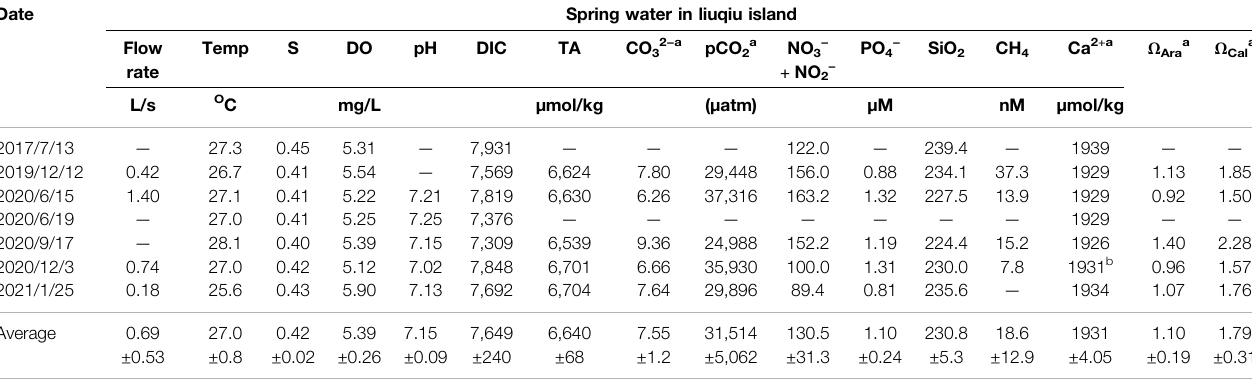
TABLE 2| Flow rate,temperature,salinity,DO, pH ontheNBSscale,DIC, TA,CO 32- ,pCO 2 ,NO 3 − +NO 2 − ,PO 43- ,SiO 2 ,CH 4 , Ca 2+ , Ω Ara , and the Ω Cal ofthespringwaterat S5 on Liuqiu Island between 2017 and 2021. Date Spring water in liuqiu island Flow